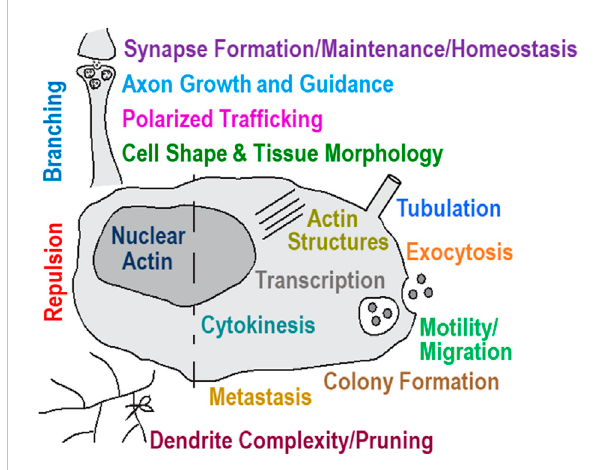
Cellular behavior controlled by the MICAL ’ s activity contributes to multiple functions and dysfunctions in numerous tissues. Modi fi ed from (Alto and Terman,